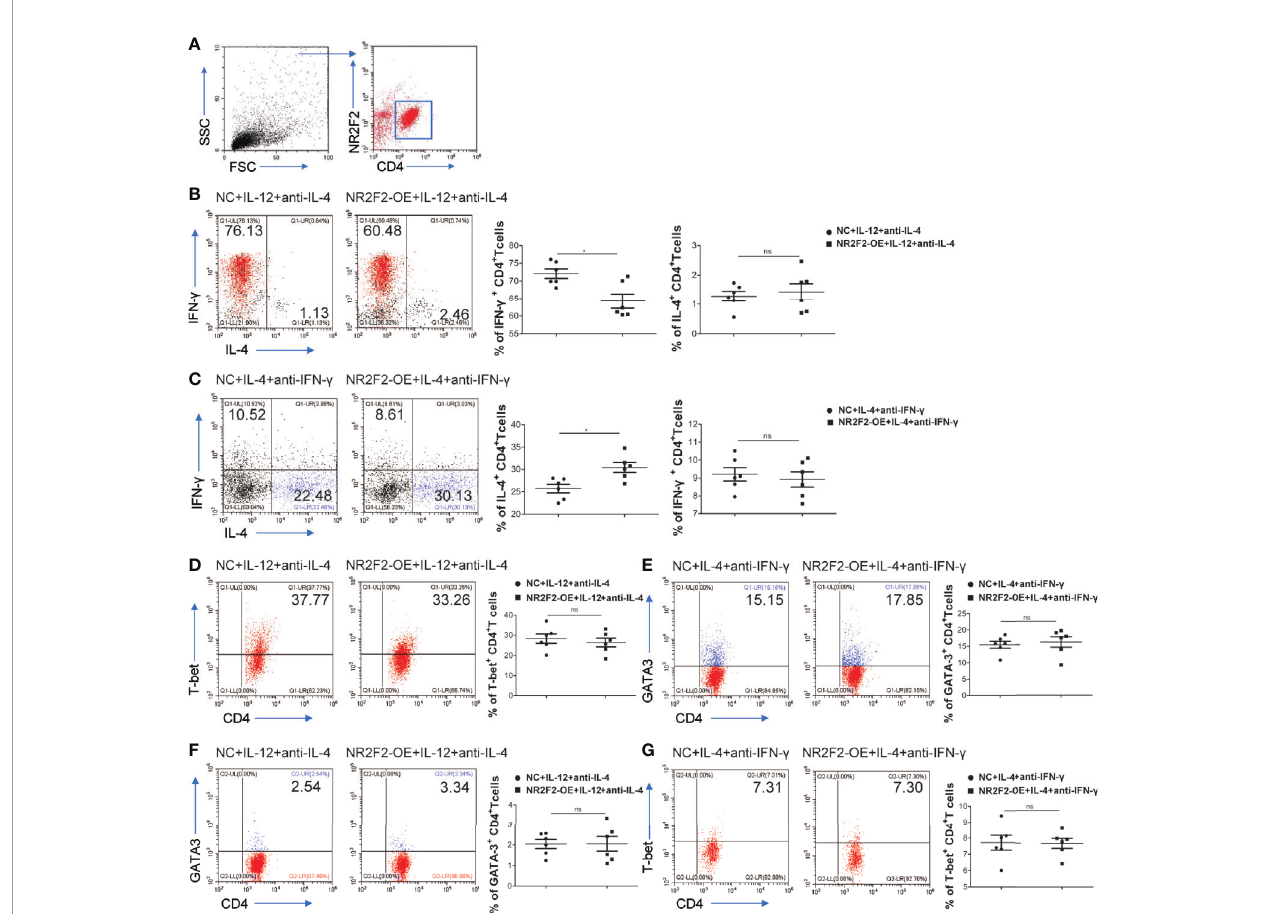
FIGURE 4 | NR2F2 promotes Th2 differentiation with the inhibition of Th1 skewing. Naive CD4 + T cells from UBMC were infected with NR2F2 overexpressed- lentivirus which also expressed GFP. (A) Gating strategy of naive CD4 + T cells from UBMC, CD4 + GFP + cells were used for further analysis. (B) UBMC naive CD4 + T cells were in vitro cultured in the presence of anti-CD3 plus anti- CD28 mAbs and of IL-12 and anti-IL-4 for Th1 differentiation. After 5 days, cells were harvested and evaluated by fl ow cytometry. (C) UBMC naive CD4 + T cells were in vitro treated with IL-4 and anti-IFN- g for Th2 differentiation and cells were collected 7 days later for fl ow cytometry detection. (D) The expression of T-bet was detected during Th1 differentiation by fl ow cytometry. (E) The expression of GATA-3 was detected during Th2 differentiation by fl ow cytometry. (F) The expression of GATA-3 was detected during Th1 differentiation by fl ow cytometry. (G) The expression of T-bet was detected during Th2 differentiation by fl ow cytometry. Data are presented as the mean ± SEM (n = 6). *P < 0.05; ns, not signi fi